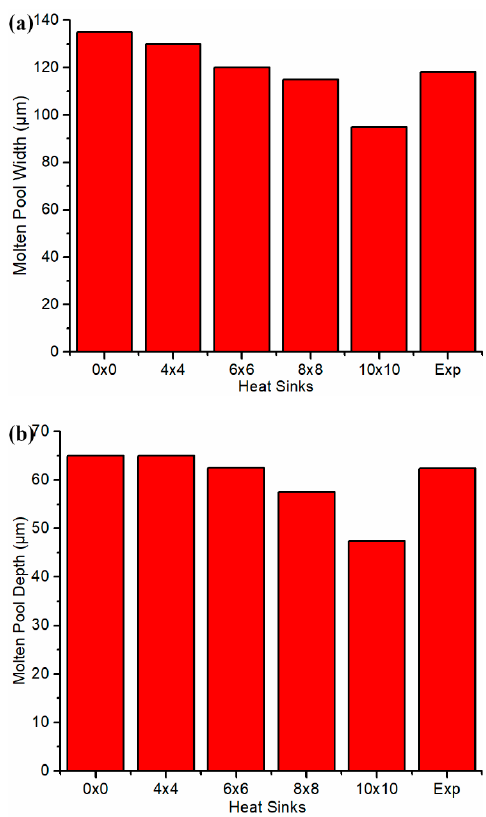
Figure 8. Determination of the number of heat sinks from the comparison between calculated molten pool dimensions and experimental measurements. Note: Exp denotes documented experimental values under test 1 conditions. ( a ) molten pool width ( b ) molten pool